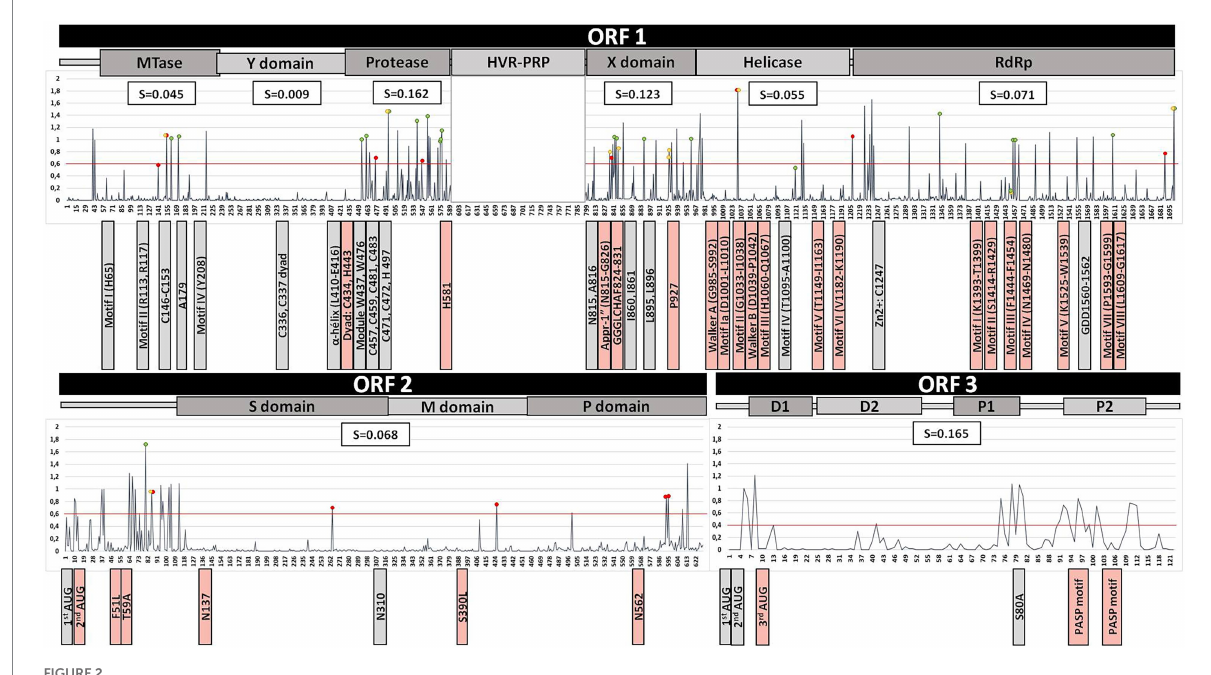
FIGURE 2 Summary of the HEV-3 genome analysis, excluding the HVR region, based on the alignment of 533 sequences. Line chart shows the entropy (S) of each position throughout the HEV genome. Red, yellow, and green dots indicate the positions of polymorphisms associated with the HEV-3abjk, HEV-3chilm, and HEV-3efg clades, respectively. The red line shows an entropy level of 0.6. The average entropy of each protein is shown in the white boxes above the chart. Previously reported motifs are indicated below the chart as boxes next to their position (grey, fully conserved motifs; light-red, mutated